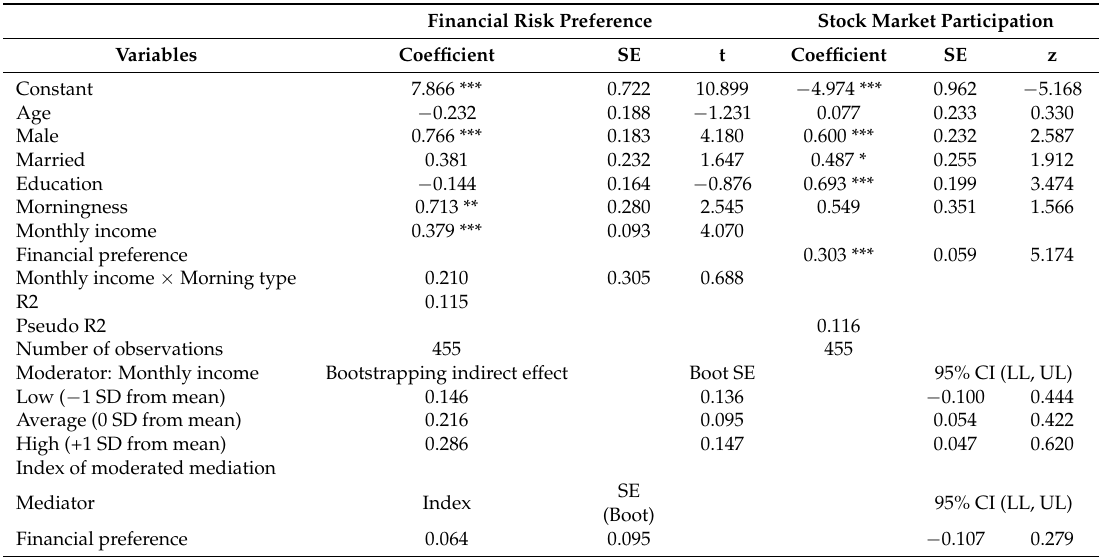
Table 10. The conditional indirect effect of morningness on stock market